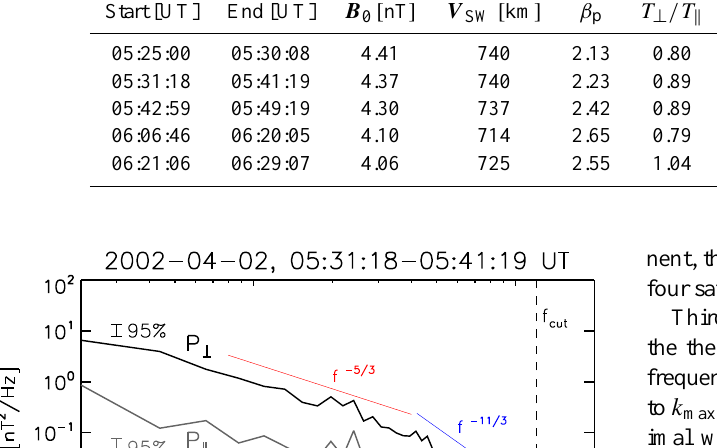
Table 1. Solar wind parameters of the five selected intervals. Electron temperatures were measured by the electron plasma instrument, PEACE (Johnstone et al., 1997).